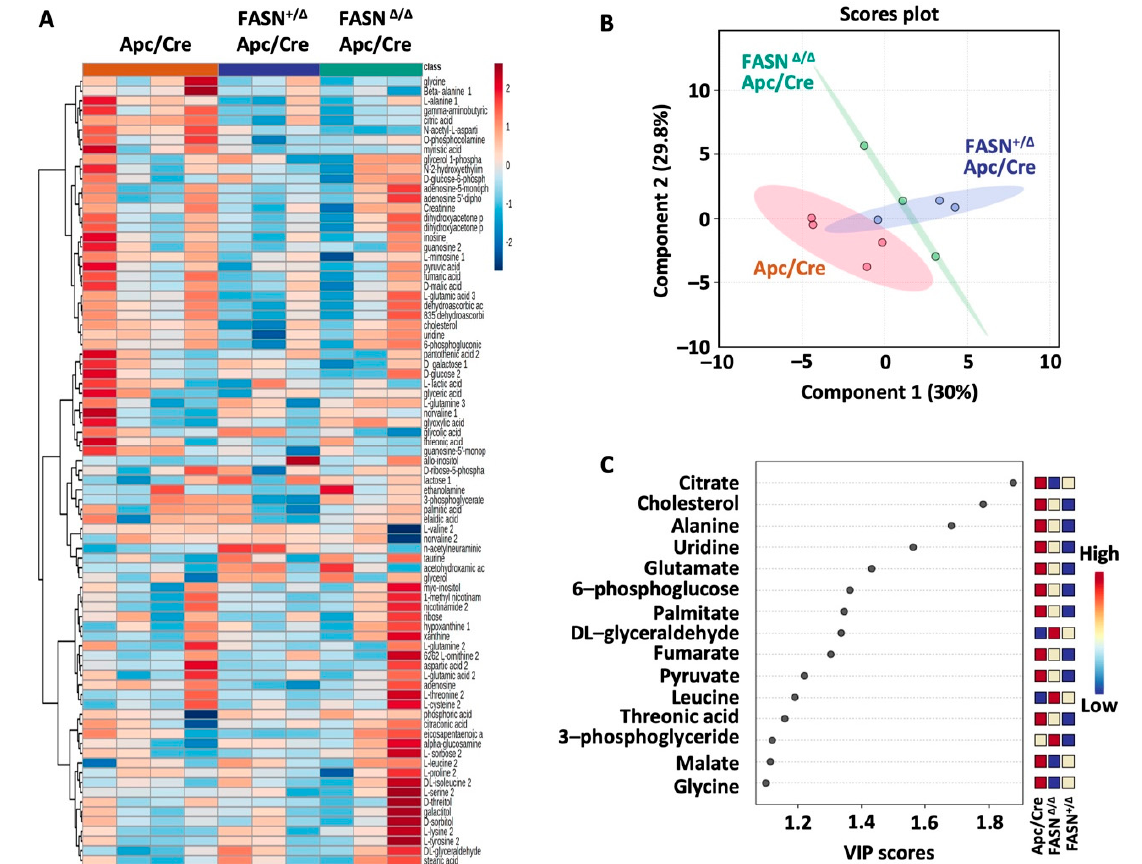
Figure 4. Downregulation of FASN is associated with alteration in multiple metabolic intermediates in mouse adenomas. ( A ) Heat map demonstrating the levels of metabolites (log normalization) identified in adenoma tissues from Apc/Cre ( n = 4) and Apc/Cre mice with hetero-( n = 3) and homozygous ( n = 3) deletion of FASN. ( B ) Partial least-squares discriminant analysis (PLS-DA) on metabolic data from Apc/Cre, FASN +/ ∆ Apc/Cre, and FASN ∆ / ∆ Apc/Cre mice. ( C ) Variable importance in projection (VIP) values from PLS-DA. The VIP score of a metabolite is calculated as a weighted sum of the squared correlations between the PLS-DA components and the original variable (FASN expression). The x -axis indicates the VIP scores corresponding to each metabolite on the y -axis.